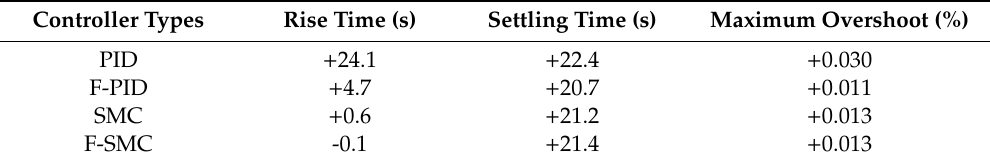
Table 9. Changes of characteristic